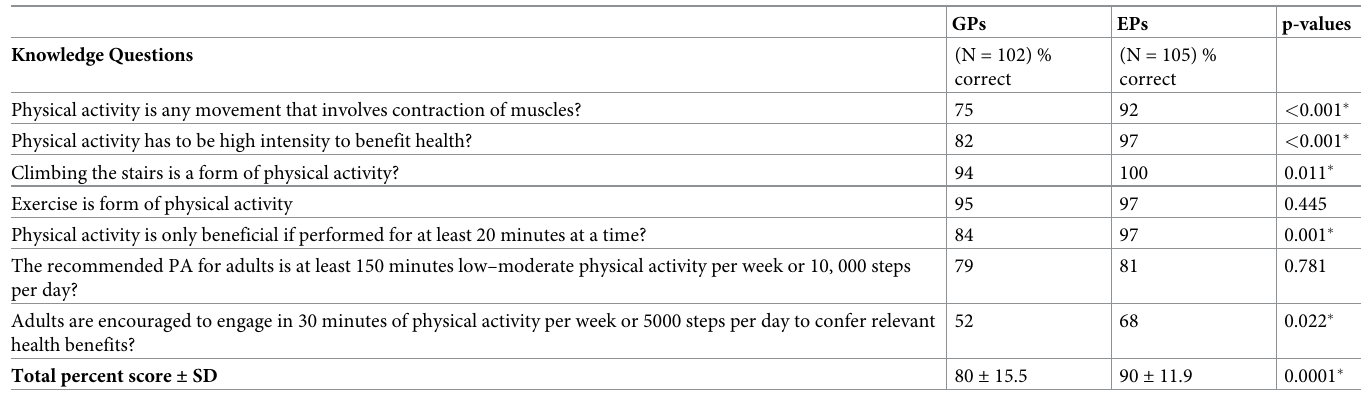
Table 3. Participants’ PA knowledge (N = 207).